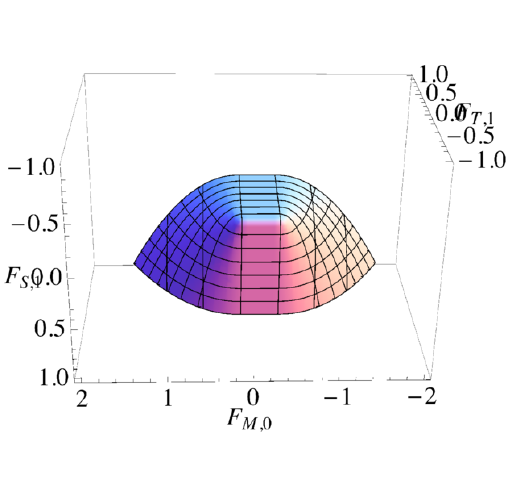
Figure 17 . Similar to (cid:12)gure 15, but imposing a restriction F M; 1 = (cid:0) 1 =